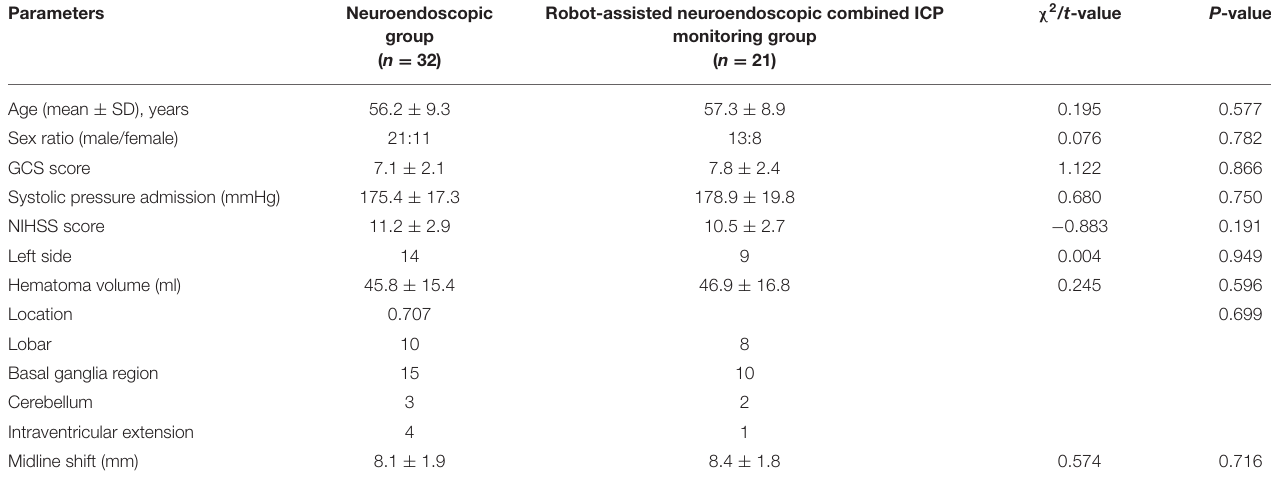
TABLE 1 | Summary of the baseline clinical characteristics of the patients.